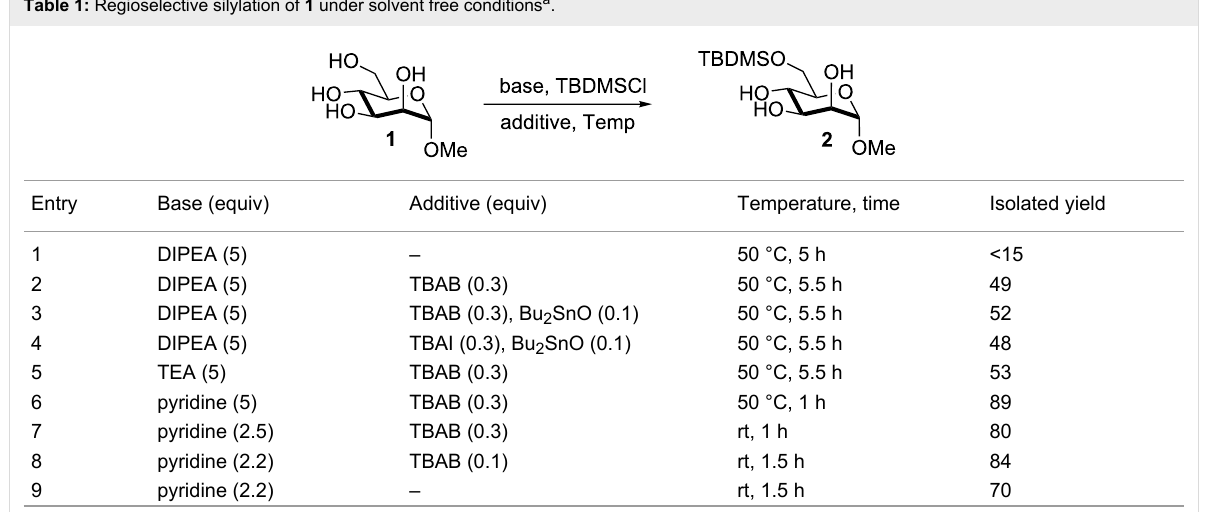
Table 1: Regioselective silylation of 1 under solvent free conditions a